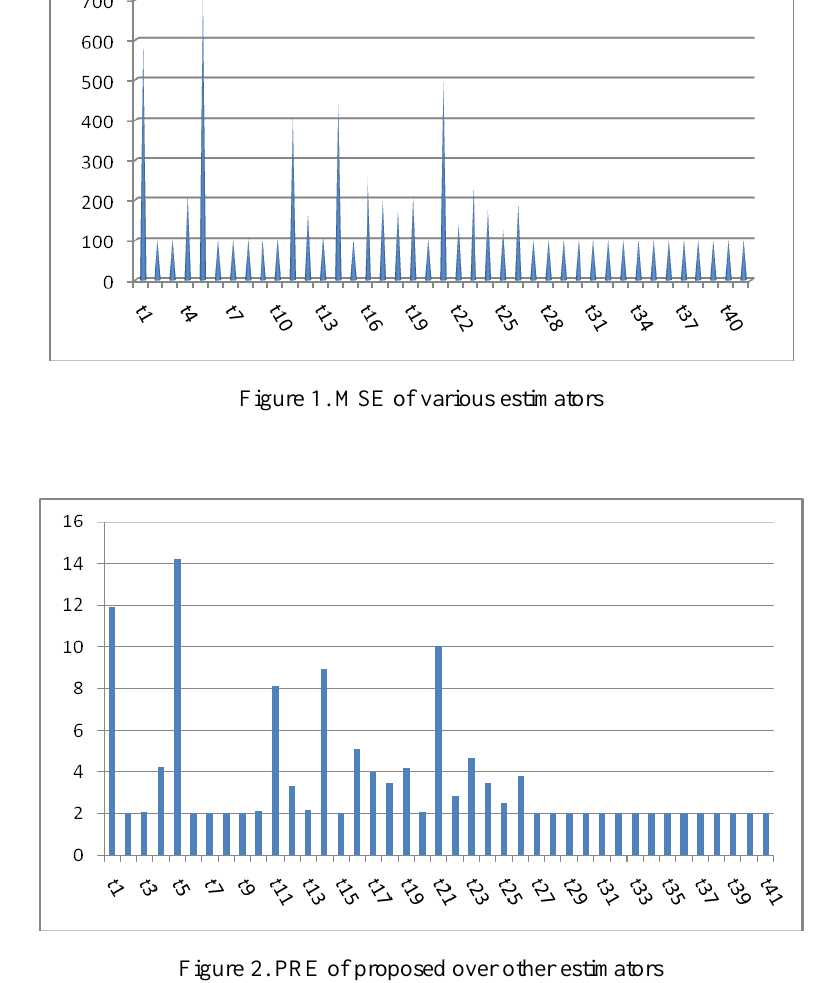
Figure 2. PRE of proposed over other